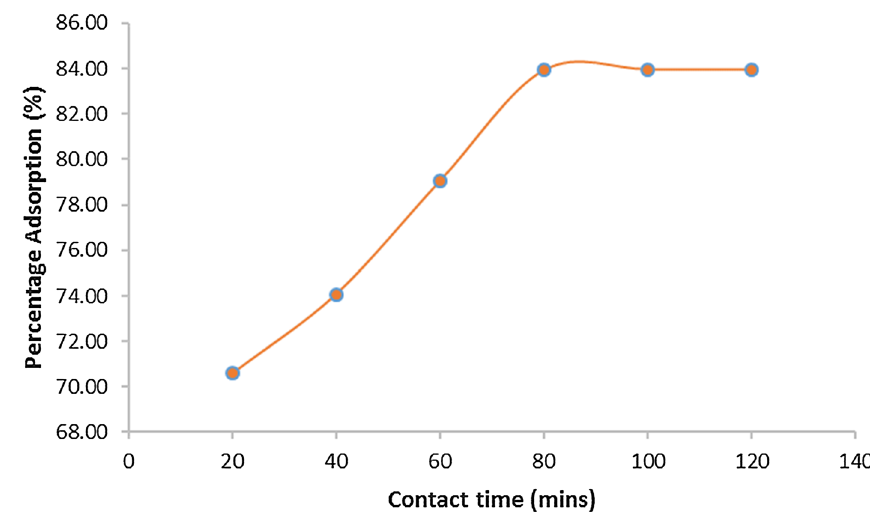
Fig.3 Influence of contact time on cyanide adsorption from cas- sava wastewater onto